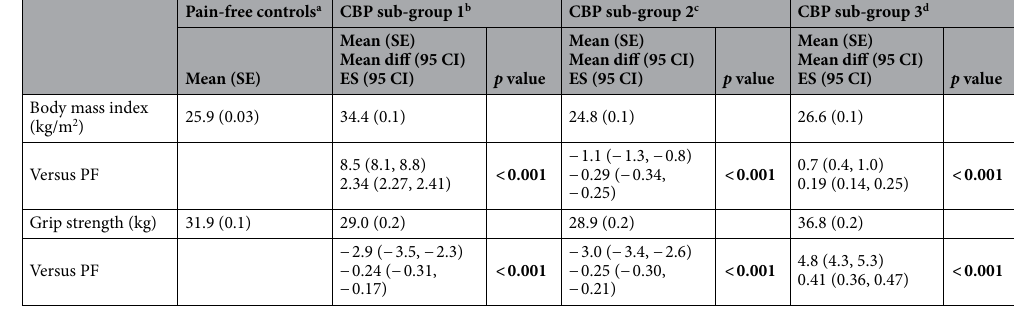
Table 3. Results of the Analysis of Covariance (ANCOVA) sub-groups derived from physical variables of body mass index and grip strength. Data are presented as adjusted mean (standard error). Adjusted mean differences and 95% confidence interval (95 CI) are reported. Effect sizes and 95% confidence intervals were calculated using standard formulae. All data were adjusted for age and sex. p value s were adjusted for multiple comparisons using Tukey HSD method. PF pain-free, 95 CI 95% confidence interval, ES effect size. Significant values are in [bold]. a Pain-free individuals (n = 14,927; 78.2%). b CBP sub-group 1: higher body mass index and low grip strength (n = 870; 4.6%). c CBP sub-group 2: lower body mass index and grip strength (n = 1933; 10.1%); d CBP sub-group 3: lower body mass index and higher grip strength (n = 1353; 7.1%).